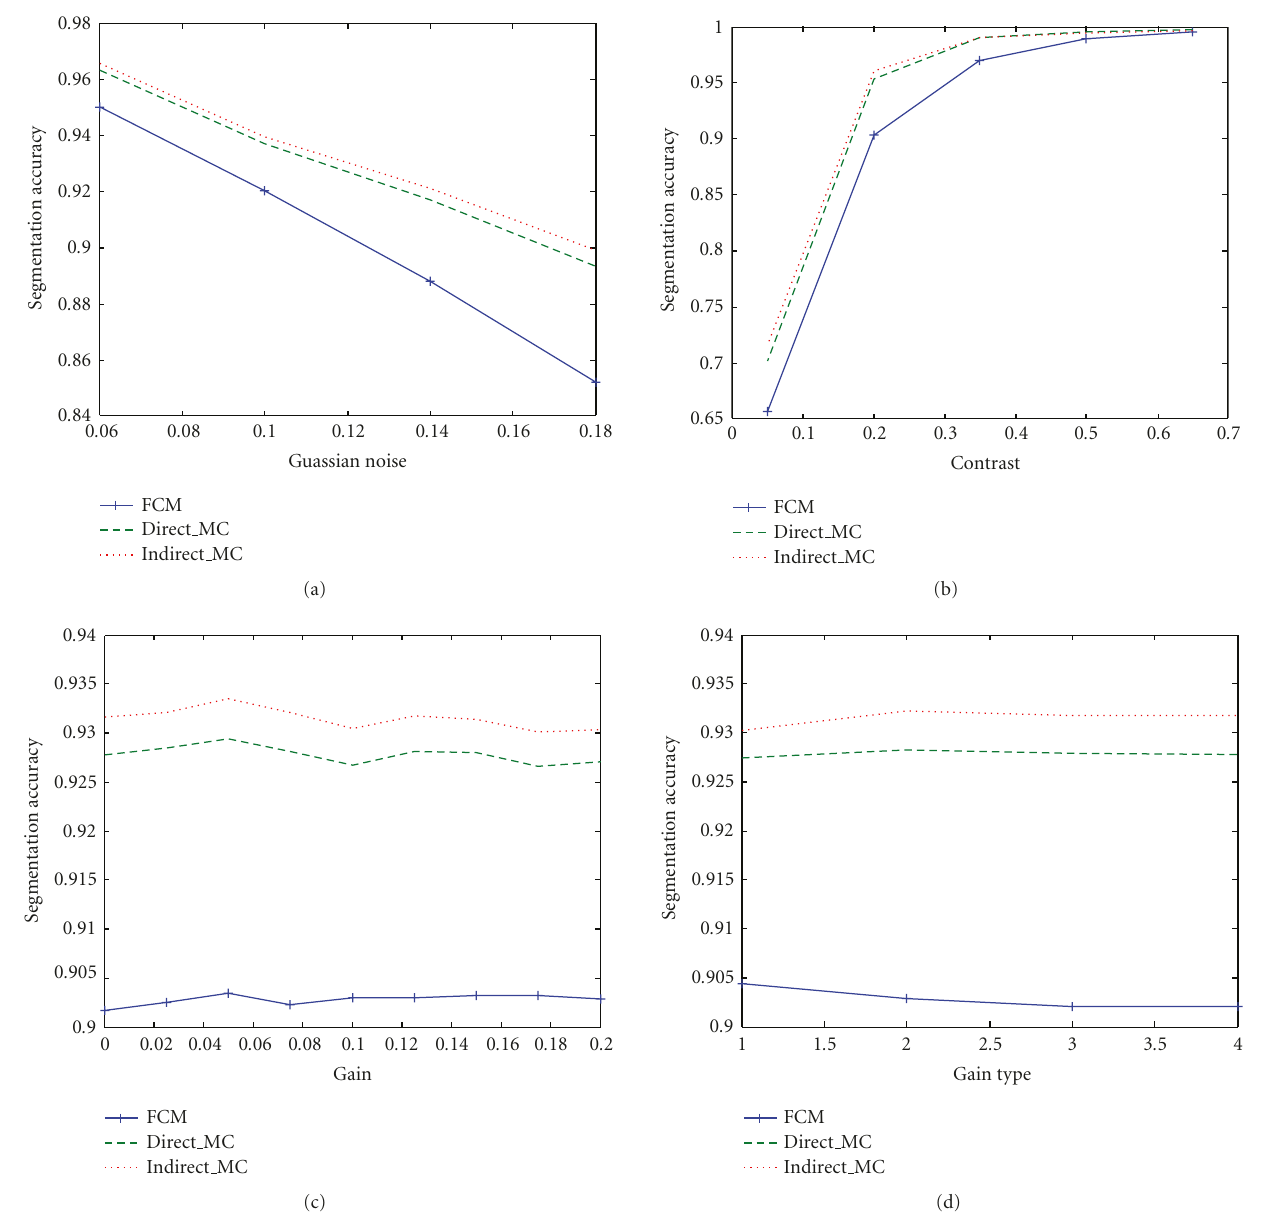
Figure 2: Segmentation accuracy versus: (a) noise variance, (b) contrast level, (c) gain factor, (d) gain type for FCM, direct-MC, and